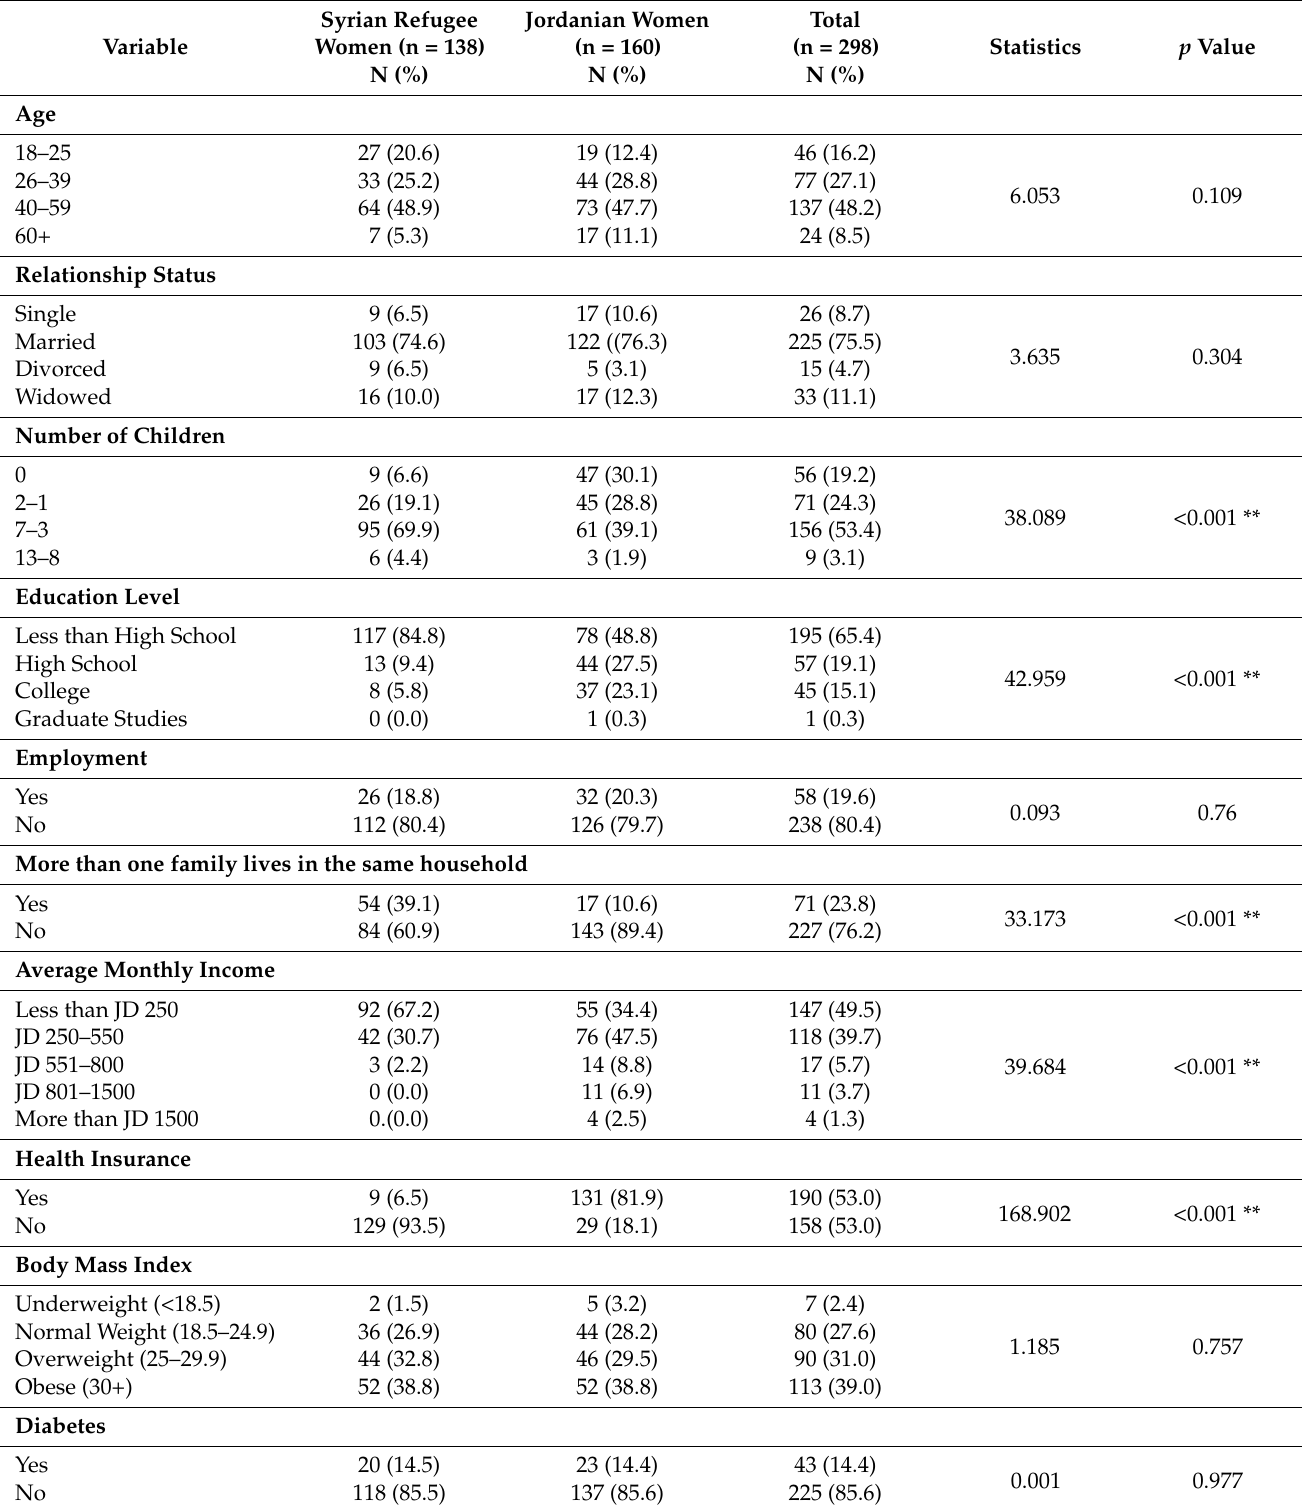
Table 1. Demographic characteristics and chronic diseases prevalence in Syrian refugee women and Jordanian